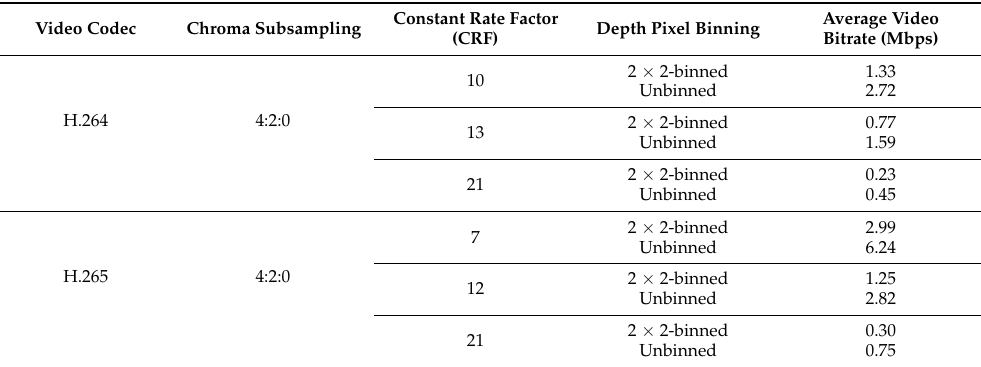
Table 2. Video compression results at select constant rate factors (CRF) of a still scene of a bust, using both 2 × 2-binned and unbinned depth sensor data. Two 582-frame recordings of a stationary bust were taken in quick succession, one using 2 × 2 depth pixel binning and the other remaining unbinned. The processing of these data are described in the first paragraph of Section 4.3. Constant rate factors (CRF) were selected to roughly align with the CRF values used in the 3, 15, and 30 Mbps encodings listed in Table 1. All MWD encodings used n stairs = 6 and other settings were as described in the first paragraph of Section